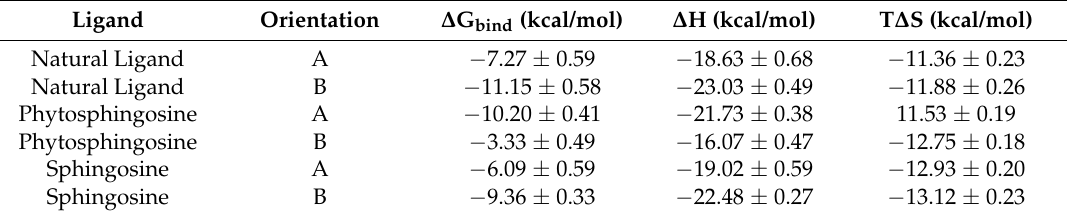
Table 1. Estimates of protein–ligand binding free energies, enthalpies, and entropies at 298 K. Ligand Orientation ∆ G bind (kcal/mol) ∆ H (kcal/mol) T ∆ S (kcal/mol) Natural Ligand A − 7.27 ±